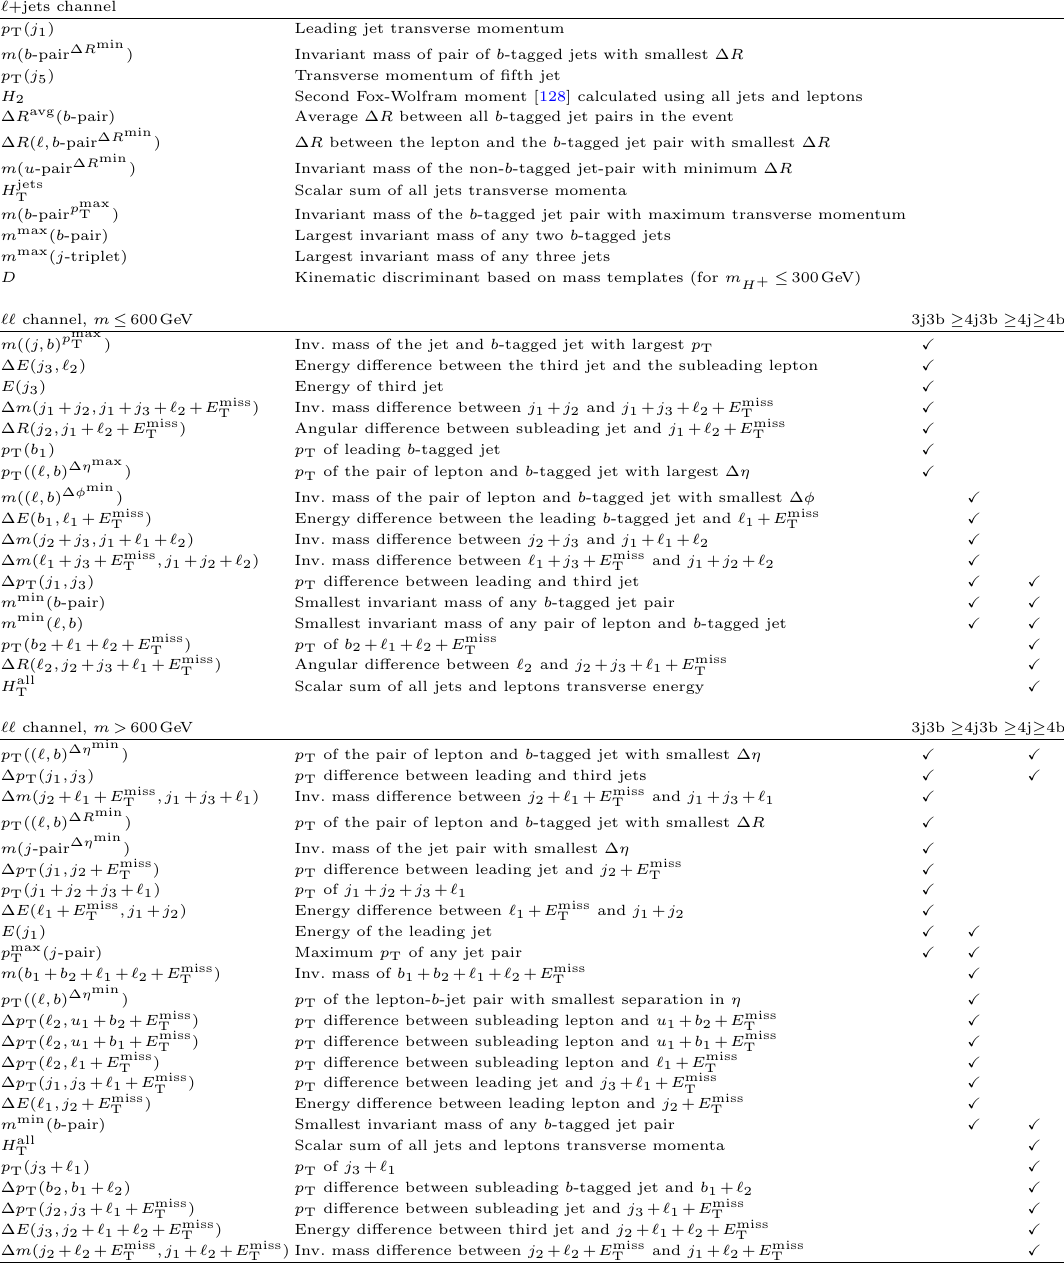
Table 6. Input variables to the classi(cid:12)cation BDT in the ‘ +jets and ‘‘ channels. The symbols j , b , u , ‘ and E miss represent the four-momenta of jets, b -tagged jets, non- b -tagged jets, the lepton and T the missing transverse momentum. All numbered indices refer to ordering in transverse momentum, with 1 as leading. The SRs where the variables are used are indicated for the ‘‘ channel. In the ‘ +jets channels the variables are used for all channels. In the ‘ +jets channel the discriminant, D , is only used for charged Higgs boson masses m (cid:20) 300 GeV. For the ‘‘ channel a very large set of H + kinematic variables using combinations of the analysis objects was examined, and approximately ten optimal variables were selected for each SR independently for the low-mass region ( m (cid:20) 600 GeV) H + and the high-mass region ( m > 600 GeV). H +